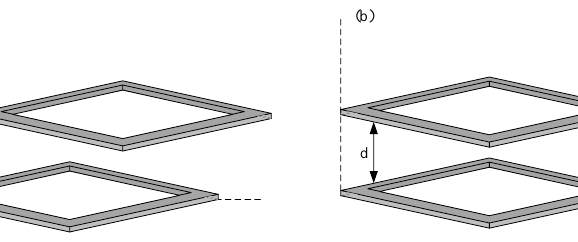
Figure 4. Changing the position: horizontally ( a ), vertically ( b ), and at the angle ( c ) of the transmitting and receiving coils with a rectangular cross-section.